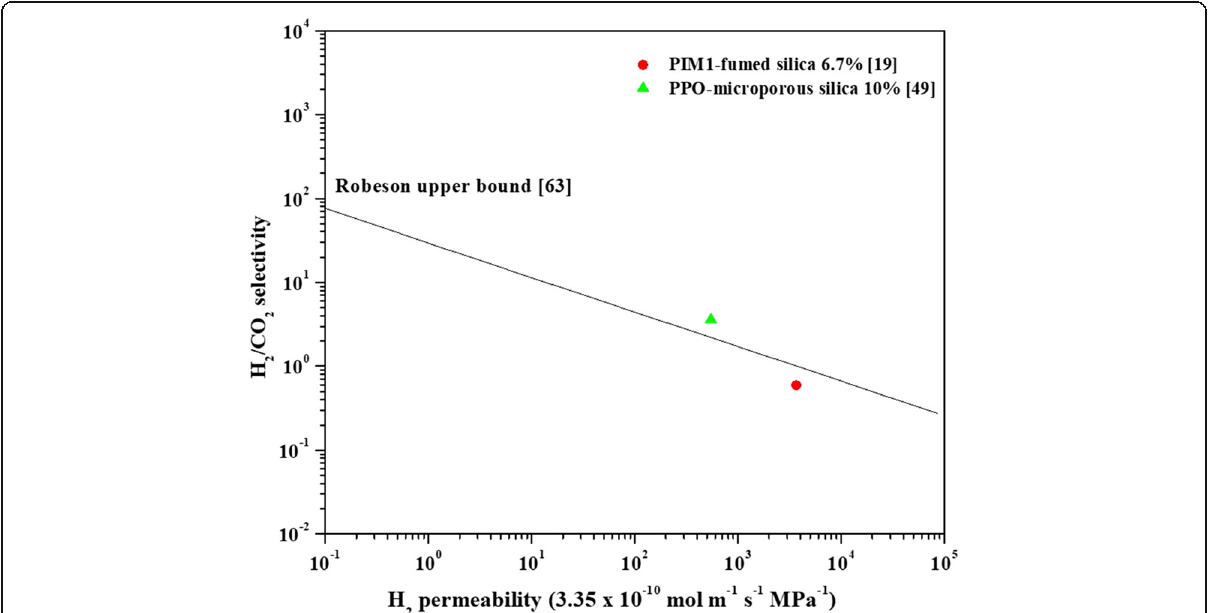
Fig. 15 H 2 /CO 2 selectivity of MMMs compared to Robeson ’ s upper bound [63] (PIM-1: soluble form of polymers of intrinsic microscopy; PPO: polyphenylene